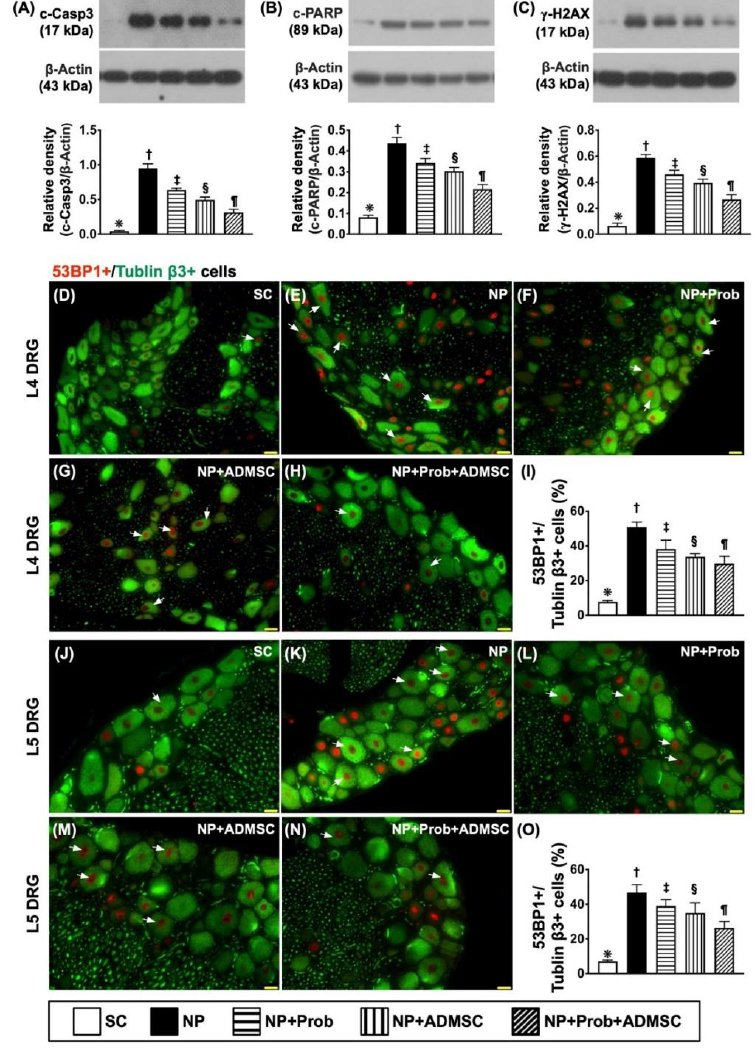
Figure 4. Protein expressions of apoptosis and DNA-damaged biomarkers and cellular expression of DNA damage in L4-L5 DRGs by day 60 after NP induction. ( A ) Protein expression of cleaved caspase 3 (c-Casp3), * vs. other groups with different symbols (†, ‡, §, ¶), p < 0.0001. ( B ) Protein expression of cleaved PARP1 poly(ADP-ribose) polymerase (c-PARP), * vs. other groups with different symbols (†, ‡, §, ¶), p < 0.0001. ( C ) Protein expression of γ -H2AX, * vs. other groups with different symbols (†, ‡, §, ¶), p < 0.0001. L4 DRG level: ( D – H ) Showing the immunofluorescent (IF) microscopic findings (400 × ) to identify merged (red–green co-localization), positively-stained 53PB1 (red color), and Tubulin β 3 (green color). Note that the white arrows indicated the merged double stain of 53PB1+/Tubulin β 3+. ( I ) Analytical results of number (%) of 53PB1+ cells compared to total Tubulin β 3+ cells, * vs. other groups with different symbols (†, ‡, §, ¶), p < 0.0001. (n = 6 for each group). L5 DRG level: ( J – N ) Showing IF microscopic findings (400×) to identify merged (red-green co-localization), positively-stained 53PB1 (red color), and Tubulin β3 (green color). Note that the white arrows indicate the merged double stain of 53PB1+/Tubulin β3+. ( O ) Analytical results of number (%) of 53PB1+ cells compared to total Tubulin β 3+ cells, * vs. other groups with different symbols (†, ‡, §, ¶), p < 0.0001. Scale bars in the lower-right corner represent 20 µ m. Noted that positively stained 53PB1 indicates DNA-damaged markers, whereas the Tubulin β 3 indicates the microtubule element of the tubulin in neurons. Symbols (*, †, ‡, §, ¶) indicate significance for each other (at 0.05 level). All statistical analyses were performed using one-way ANOVA followed by Bonferroni multiple comparison post hoc test (n = 8 for each group). SC = sham control; NP = neuropathic pain; Prob = probiotics; ADMSCs = adipose-tissue-derived mesenchymal stem